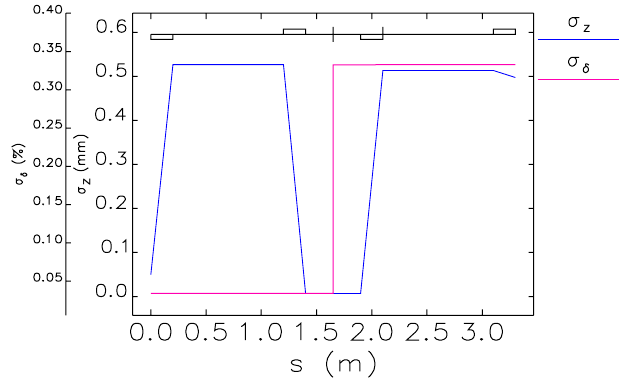
FIG. 5. (Color) The rms bunch length and energy spread in the emittance exchange system where the effective bunch length is quite long during most of the transport, due to the large initial bend-plane beta function and